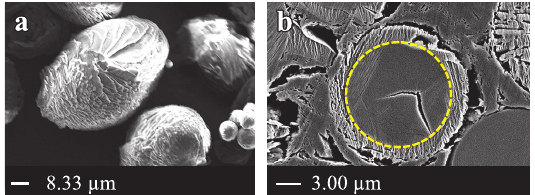
Fig. 6 SEM photographs of composite particles of starch with glycine prepared by ultrasonic spray nozzle: (a) composite particles; (b) cross section of composite particle framed by dot-line is the starch of the core particle. Reprinted with permission from Ref. (Gonda et al., 2015). Fig. 7 Schematic of the composite particle. Guest particles on the core particles precipitated through a liquid-liquid interfacial